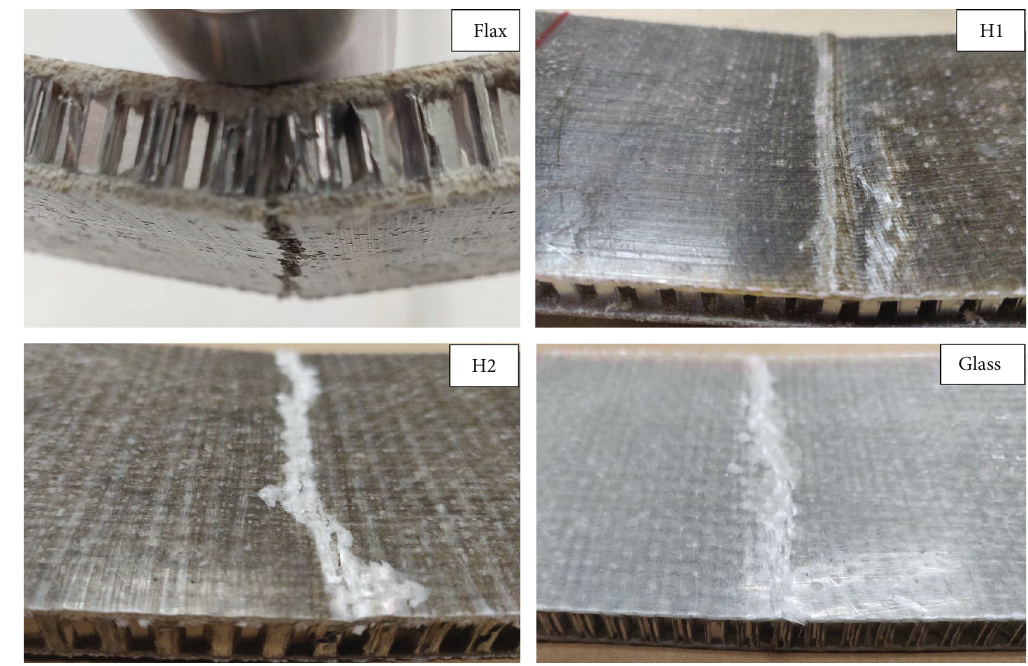
Figure 11: Collapse mode of sandwich structures subjected to the fl exural test. Table 6: Dimensions and fl exural sti ff ness of the composite sandwich